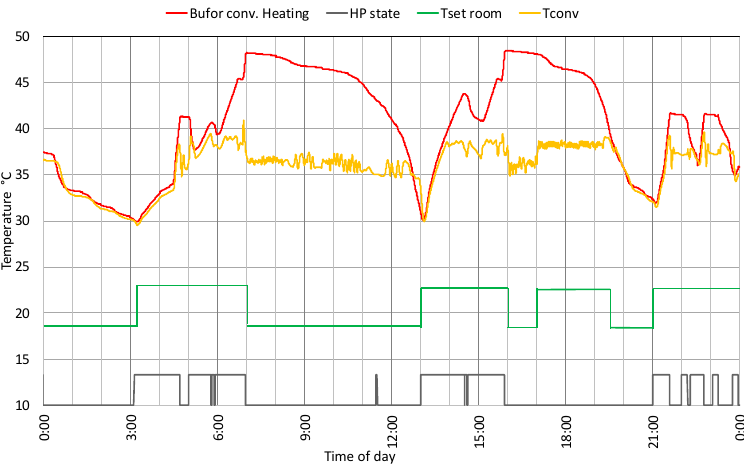
Figure 8. Temperatures in the HB 2 and circuits, and HP state, on work days.